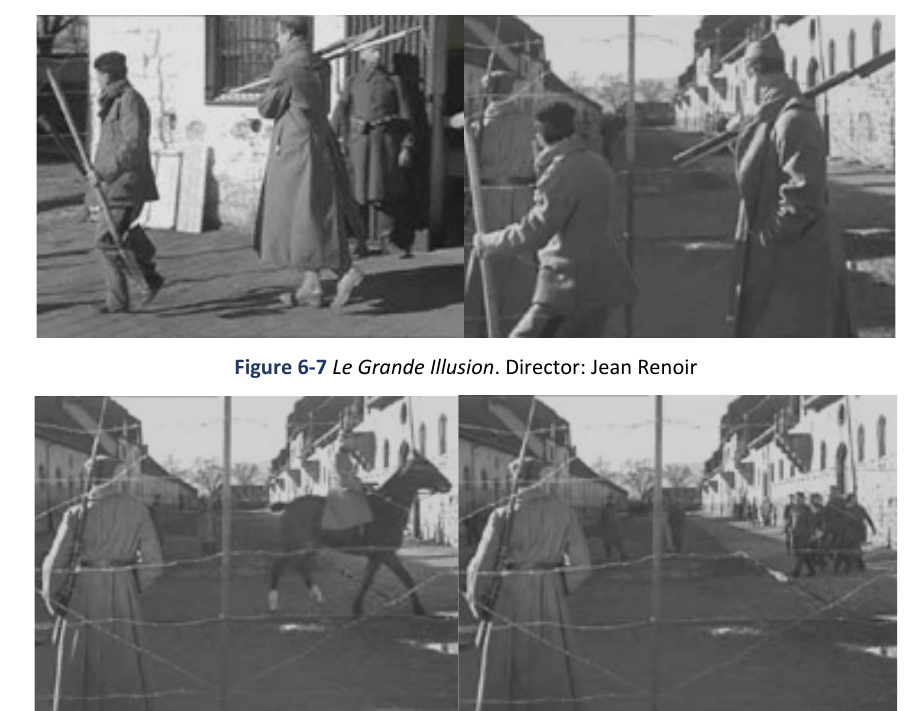
Figures 7-8 Le Grande Illusion . Director: Jean